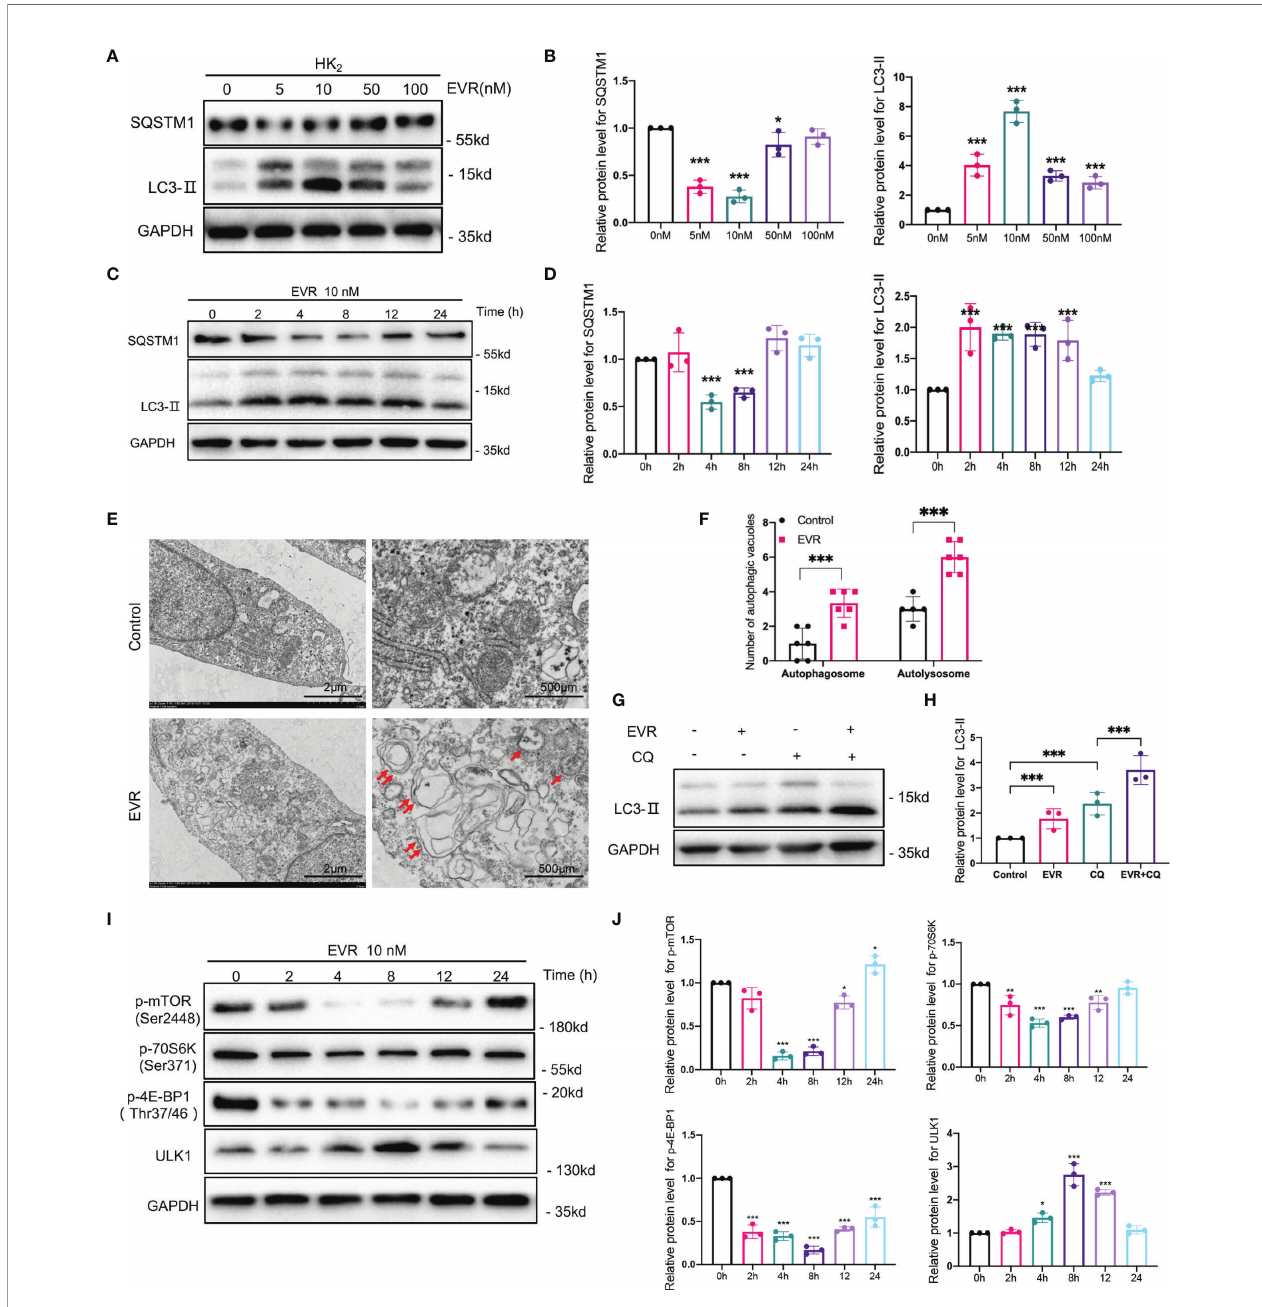
FIGURE 4 | EVR activated autophagic fl ux through mTOR/ULK1 pathway in HK2 cells. (A) Representative Western blotting results of the expressions of SQSTM1 and LC3-II in HK2 cells after EVR treatment for different dosages. (B) Semi-quantitative analyses results of relative protein abundances of SQSTM1 and LC3-II in HK2 cells after EVR treatment for different dosage. Values represented the mean ± SD ( n = 6, * p < 0.05, *** p < 0.001). (C) Representative Western blotting results of the expressions of SQSTM1 and LC3-II in HK2 cells after EVR treatment for different times. (D) Semi-quantitative analyses results of relative protein abundances of SQSTM1 and LC3-II in HK2 cells after EVR treatment for different times. Values represented the mean ± SD ( n = 6, *** p < 0.001). (E) Representative TEM images of autophagosomes (red double arrow) and autolysosomes (red single arrow) in HK2 cells treated with or without EVR (10 nM) for 24 h (scale bar: 2 and 500 m m). (F) Qualitative analyses results of the number of autophagic vacuoles in control and EVR treatment groups under TEM. Values represented the mean ± SD ( n = 6, *** p < 0.001). (G) Representative Western blotting results of the expression of LC3-II in HK2 cells treated with EVR (10 nM) and/or CQ (20 m M) for 24 h. (H) Semi- quantitative analyses results of relative protein abundance of LC3-II in HK2 cells treated with EVR and/or CQ for 24 h. Values represented the mean ± SD ( n = 6, *** p < 0.001). (I) Representative Western blotting results of the expressions of p-mTOR, mTOR, p-70S6K, 70S6K, p-4E-BP1, 4E-BP1, and ULK1 in HK2 cells after EVR treatment for different times. (J) Semi-quantitative analyses results of relative protein abundances of p-mTOR, mTOR, p-70S6K, 70S6K, p-4E-BP1, 4E-BP1, and ULK1 in HK2 cells after EVR treatment for different times. Values represented the mean ± SD ( n = 6, * p < 0.05, ** p < 0.01, *** p < 0.001). TEM, transmission electron microscope; IF, immuno fl uorescence; EVR, everolimus; CQ,